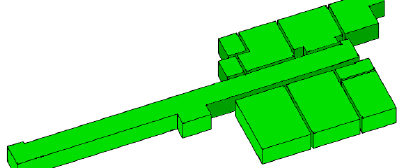
Fig. 8. The ground truth interior space of the TUB1 dataset